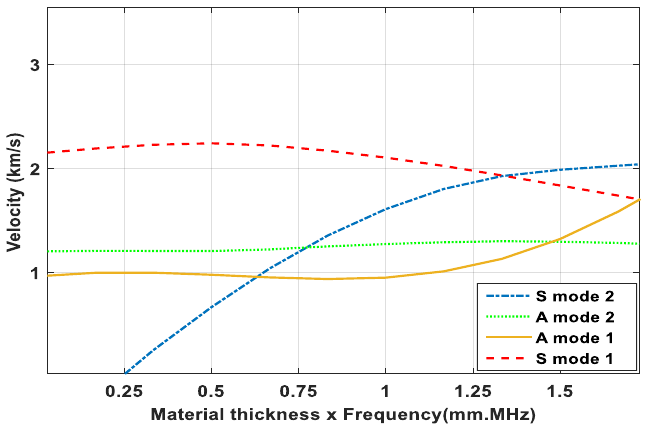
Figure 5. Wave modes for the arrival time of signals.